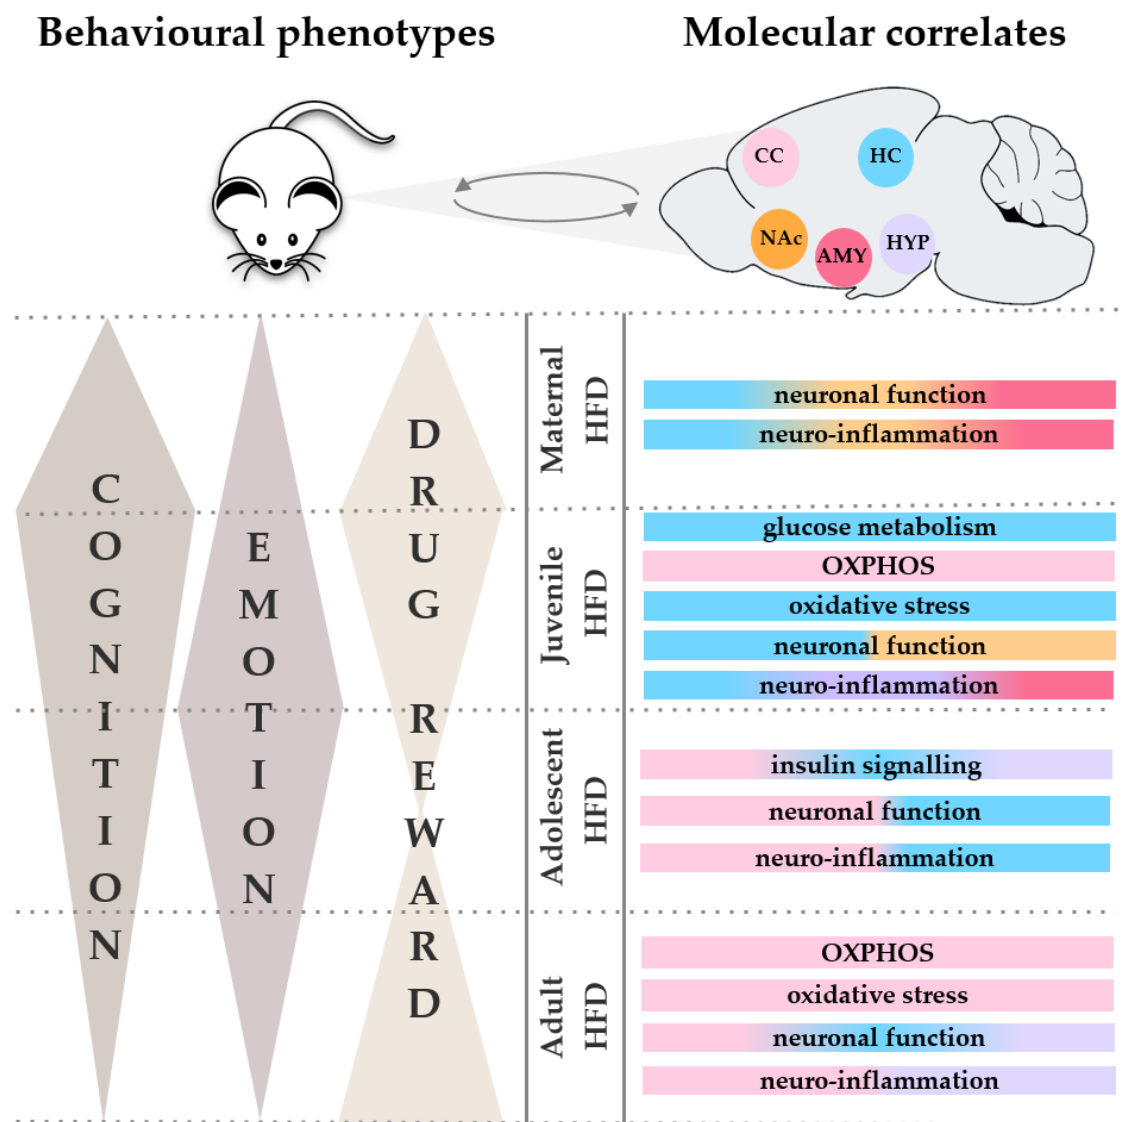
Figure 1. Overview of the impact of a high-fat diet (HFD) treatment on behavioural phenotypes (i.e., emotionality, cognition and reward-related behaviour) in rodents, as well as associated brain mechanisms. Treatment with a HFD leads to alterations in energy metabolism (i.e., glucose metabolism, insulin signalling), molecular correlates of mitochondrial functions (e.g., OXPHOS, oxidative stress and neuroinflammation) and neuronal function (i.e., neurotransmission, synaptic plasticity) in a subset of brain areas, depending on the developmental period at which the HFD is administered.